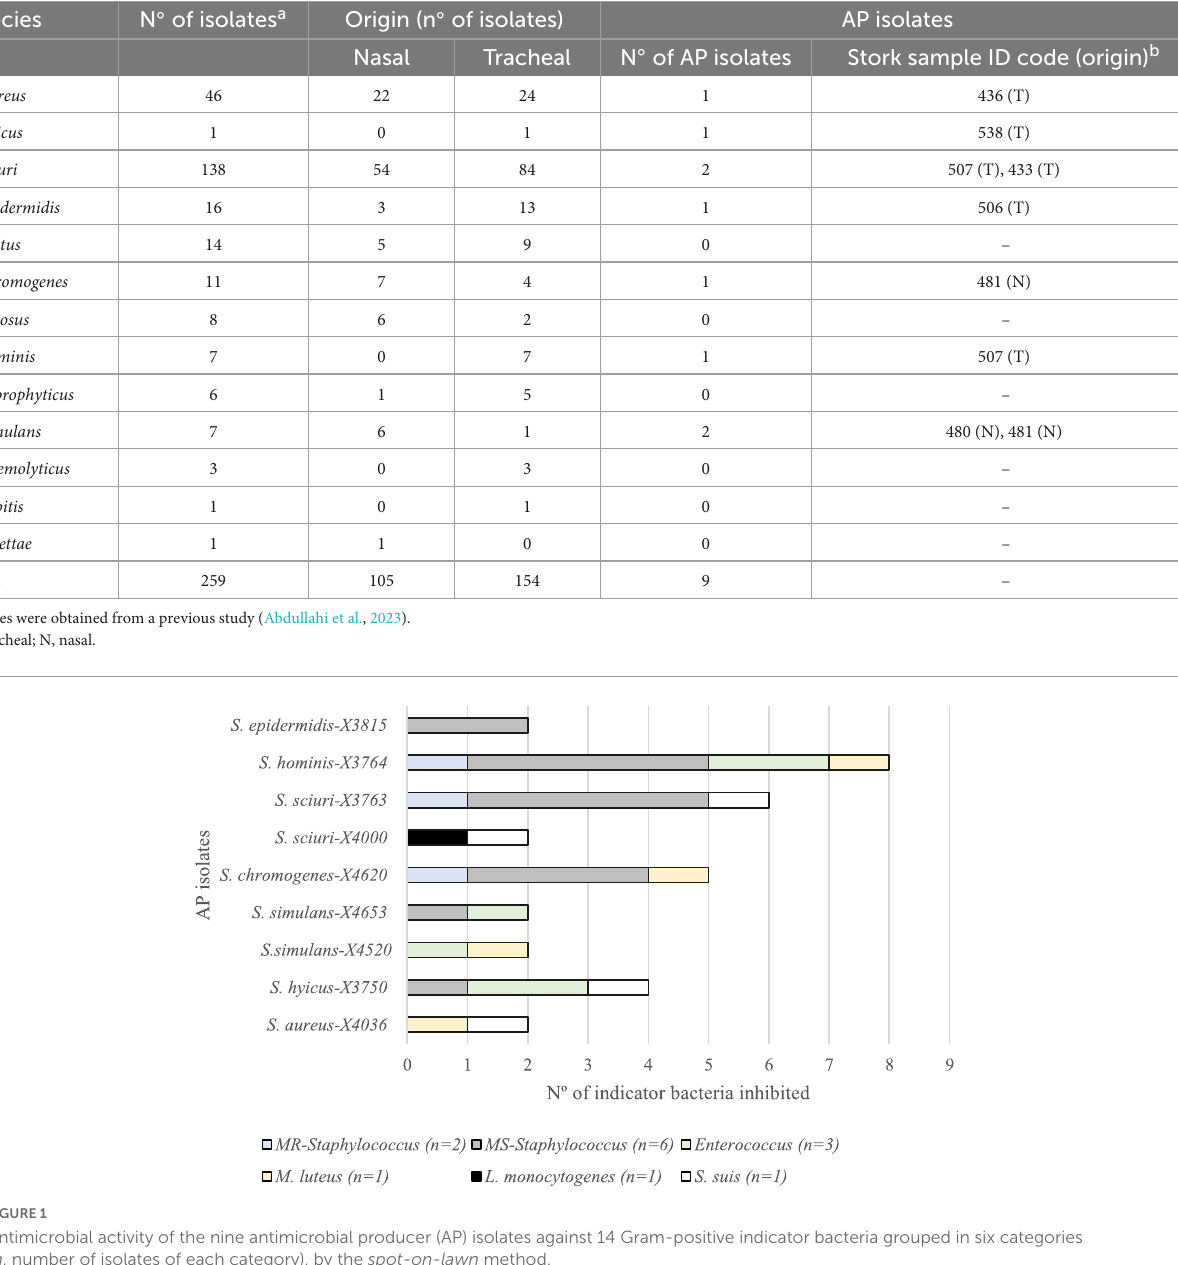
in the present study (one isolate of each Staphylococcal species per animal), which corresponded to 2–5